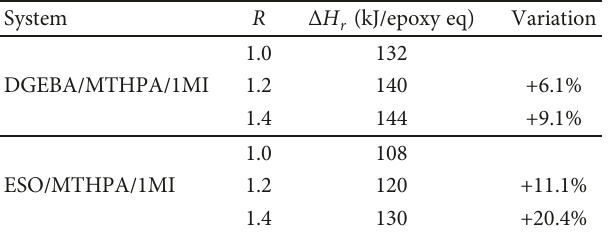
Table 3: Total heat of reaction ( Δ H of epoxy equivalents for the DGEBA/MTHPA/1MI and ESO/ MTHPA/1MI systems with di ff erent stoichiometric ratios R .